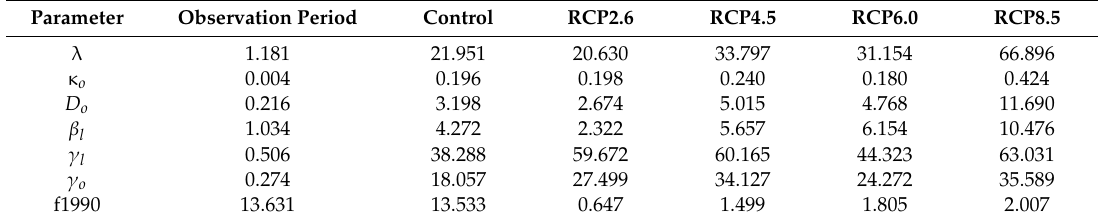
Table 2. Sobol index of parameters of MiCES model (in E-03 scale,